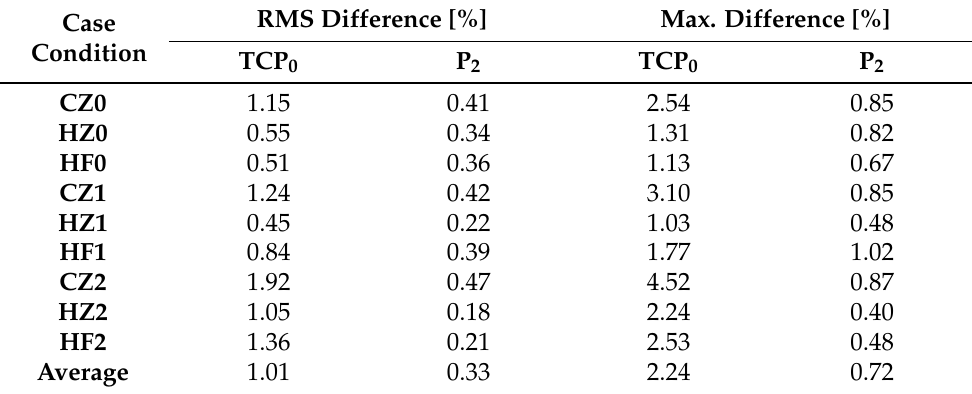
Table 5. Comparison of RMS and maximum assembly power differences for TCP 0 and P 2